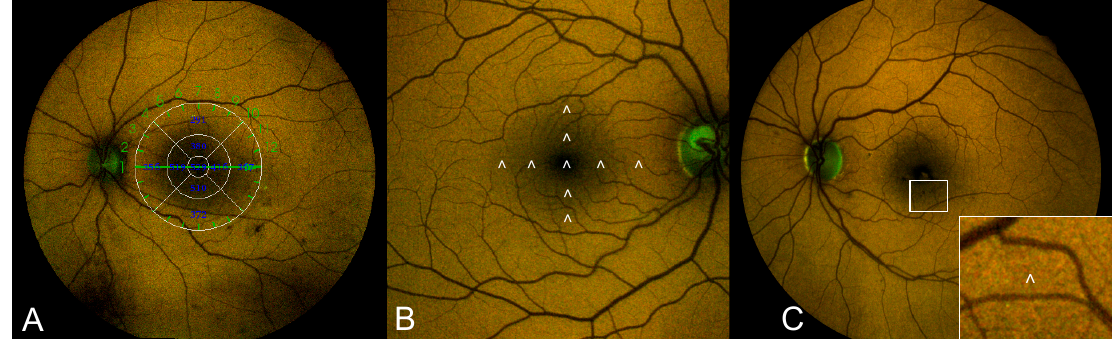
Figure 1. Example image showing the methodology used for color-FAF quantitative analysis. ( A ) Color-FAF of the posterior pole of a patient affected by DM and DR with superimposed standard ETDRS grid used as a reference for the identification of the 9 quadrants included in the analysis (corresponding values of retinal thickness are reported inside the grid); ( B ) Enlarged color-FAF of an healthy eye included as control showing the 9 sites where quantitative analysis of color-FAF parameters (GEFC/REFC intensity and emission wavelength) was performed (indicated by white arrowheads); ( C ) Color-FAF of a patient with moderate non-proliferative DR and DME showing in the white box at the bottom-right corner of the image a detail of the inner inferior quadrant: the site of analysis (indicated by the white arrowhead) was carefully chosen to select an area where no concomitant lesions (in this case microaneurysms and hemorrhages) were present. FAF: fundus autofluorescence; DM: diabetes mellitus; DR: diabetic retinopathy; ETDRS: early treatment diabetic retinopathy study; GEFC/REFC: green/red emission fluorescence components; DME: diabetic macular edema.